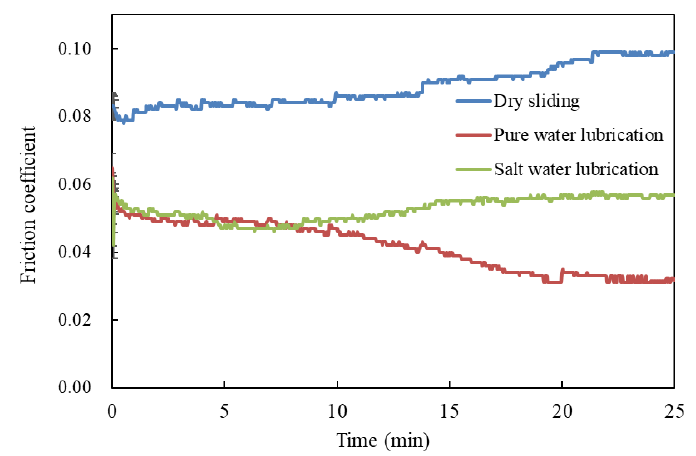
Figure 2. Variation of friction coefficient along with time under different lubrications.